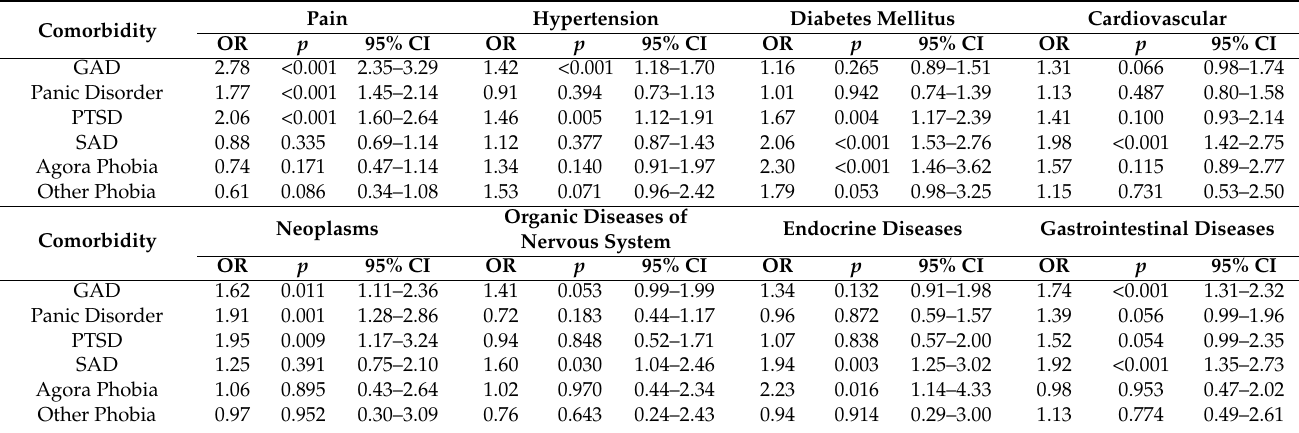
Table 4. Depression with co-occurring anxiety disorders, crude odds ratios for physical